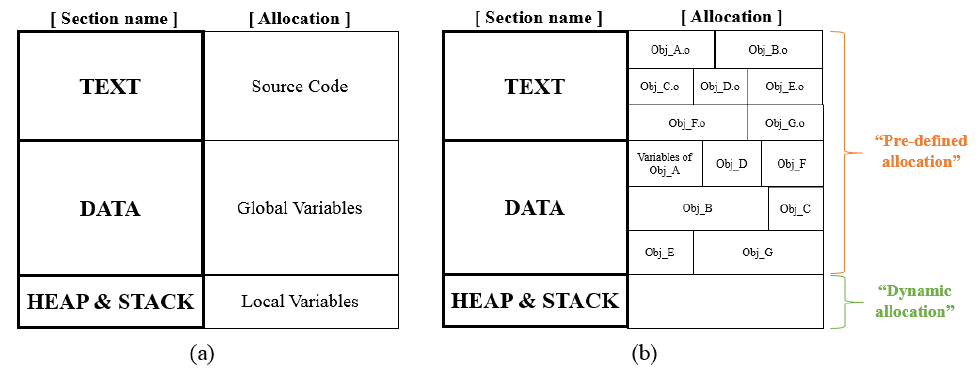
Figure 3. Memory maps for general-purpose and automotive ECU software. ( a ) General-purpose memory map; ( b ) an example of memory map for automotive ECU software.